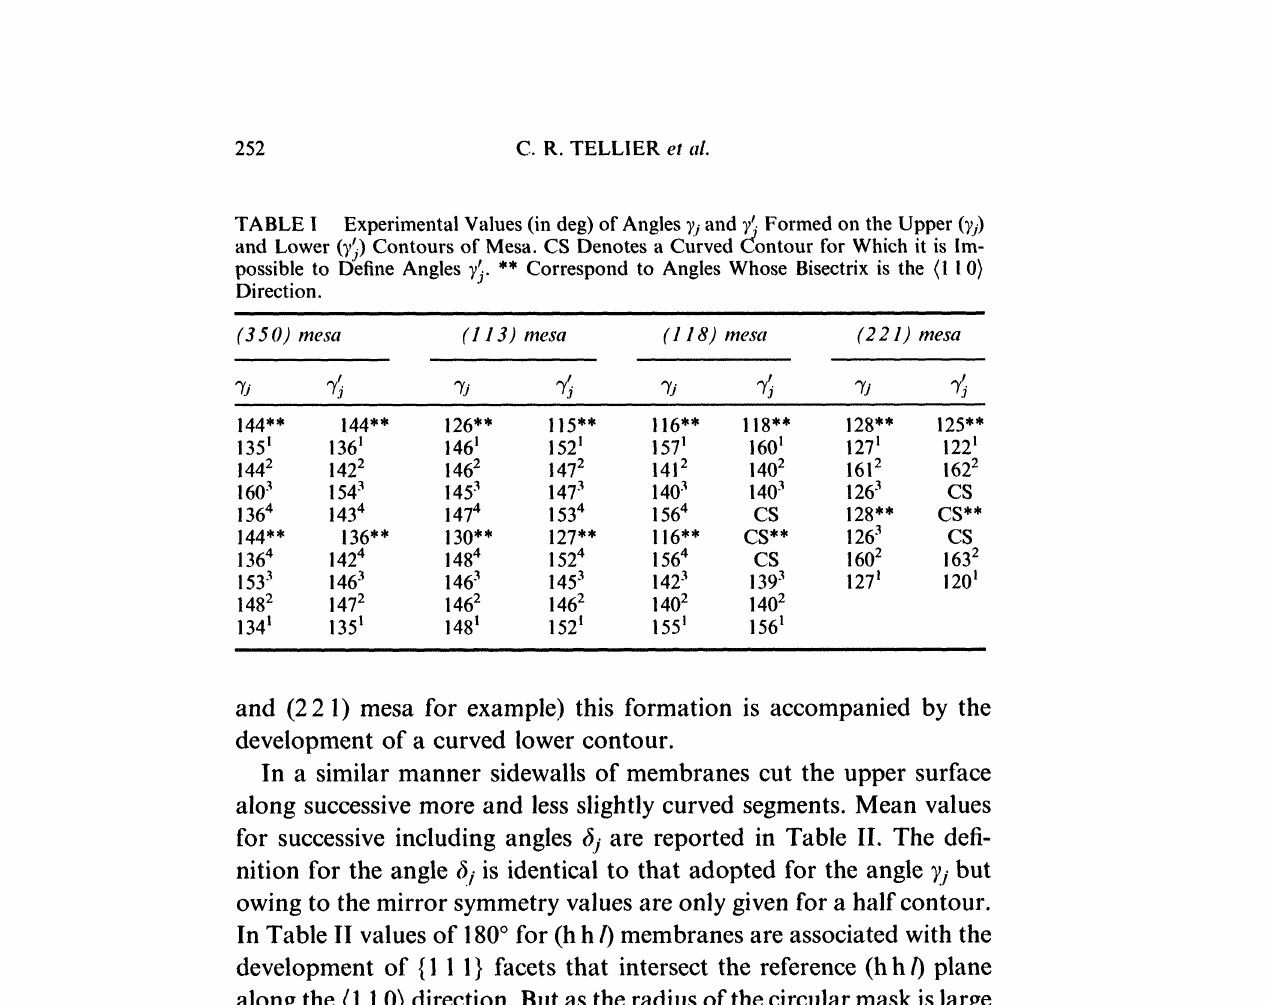
TABLE II Experimental Values (in deg) of Angles 6j Formed on the Upper Contours of Membranes. Subscript CS is Given for Angles Resulting from the Intersection of Two Curved